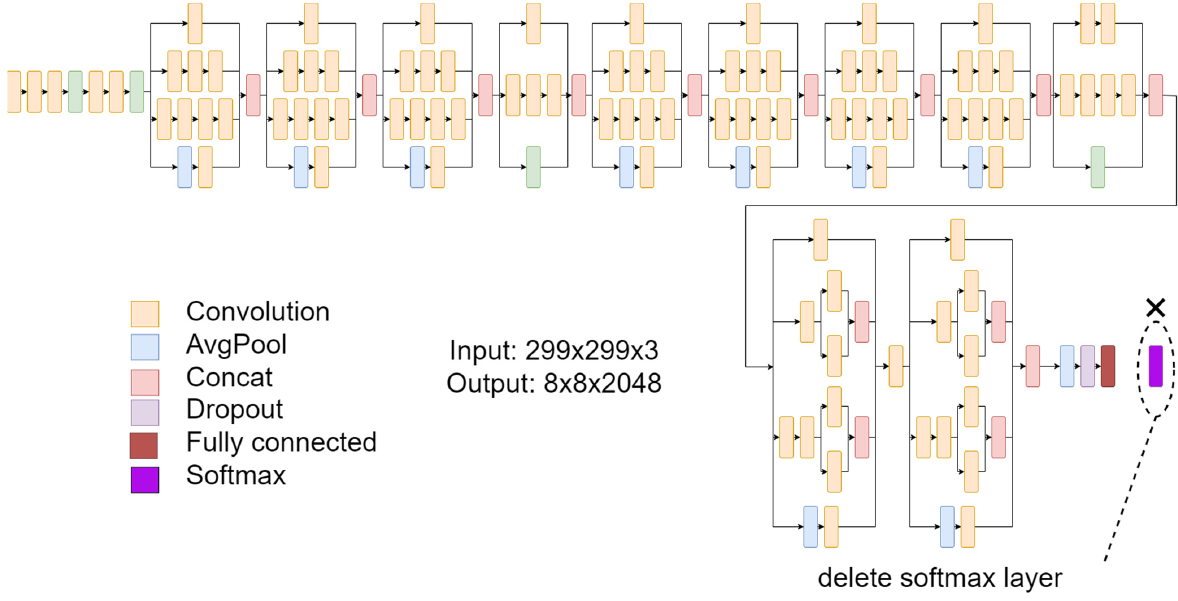
Figure 5. Structure of InceptionV3.